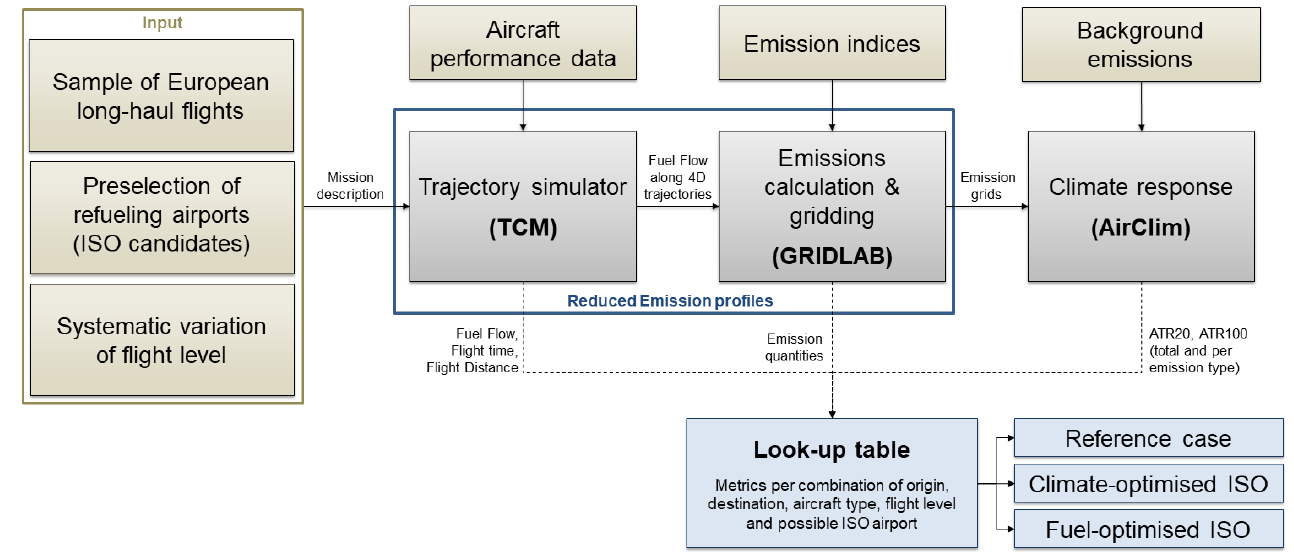
Figure 1. Modelling workflow to assess climate mitigation potential of different ISO